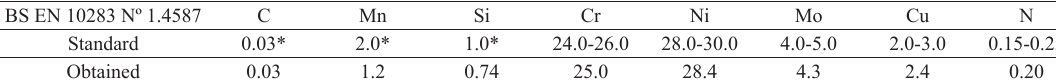
Table 1. Chemical compositions of superaustenitic steel BS EN 10283 Nº 14587 (% in weight). BS EN 10283 Nº 1.4587